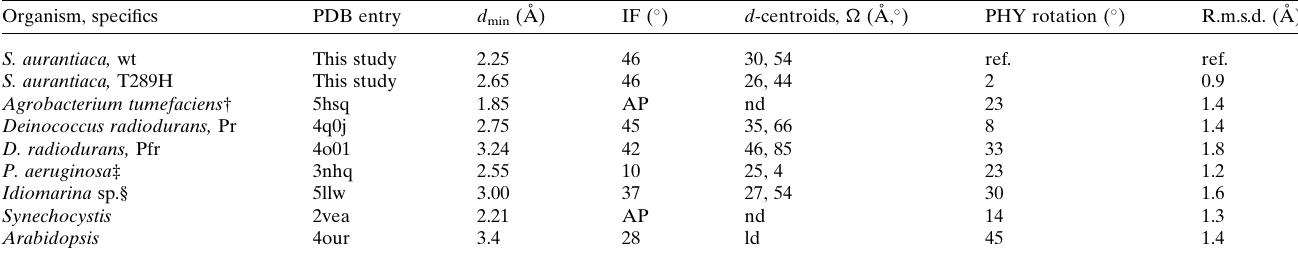
Table 2 Geometric analysis of selected BphP structures as compared with the SaBphP1-PCM-wt. Resolution limits d min are indicated. The superposition was performed by Chimera (Pettersen et al. , 2004) using Smith–Waterman alignment of C (cid:5) atoms (outliers >5 A˚ were ignored). IF, angle of relative subunit orientations at the interface; d -centroids, distance between PHY domain centroids, the opening angle (cid:3) is estimated as explained in the text and in Fig. 8( a ). The PHY domain rotation was calculated as explained. Last column: similarities (root-mean-square displacement) of PAS-GAF domain C (cid:5) atomic positions relative to SaBphP1-PCM-wt as reference. AP, antiparallel orientation; nd, not done; ld, incomplete PHY